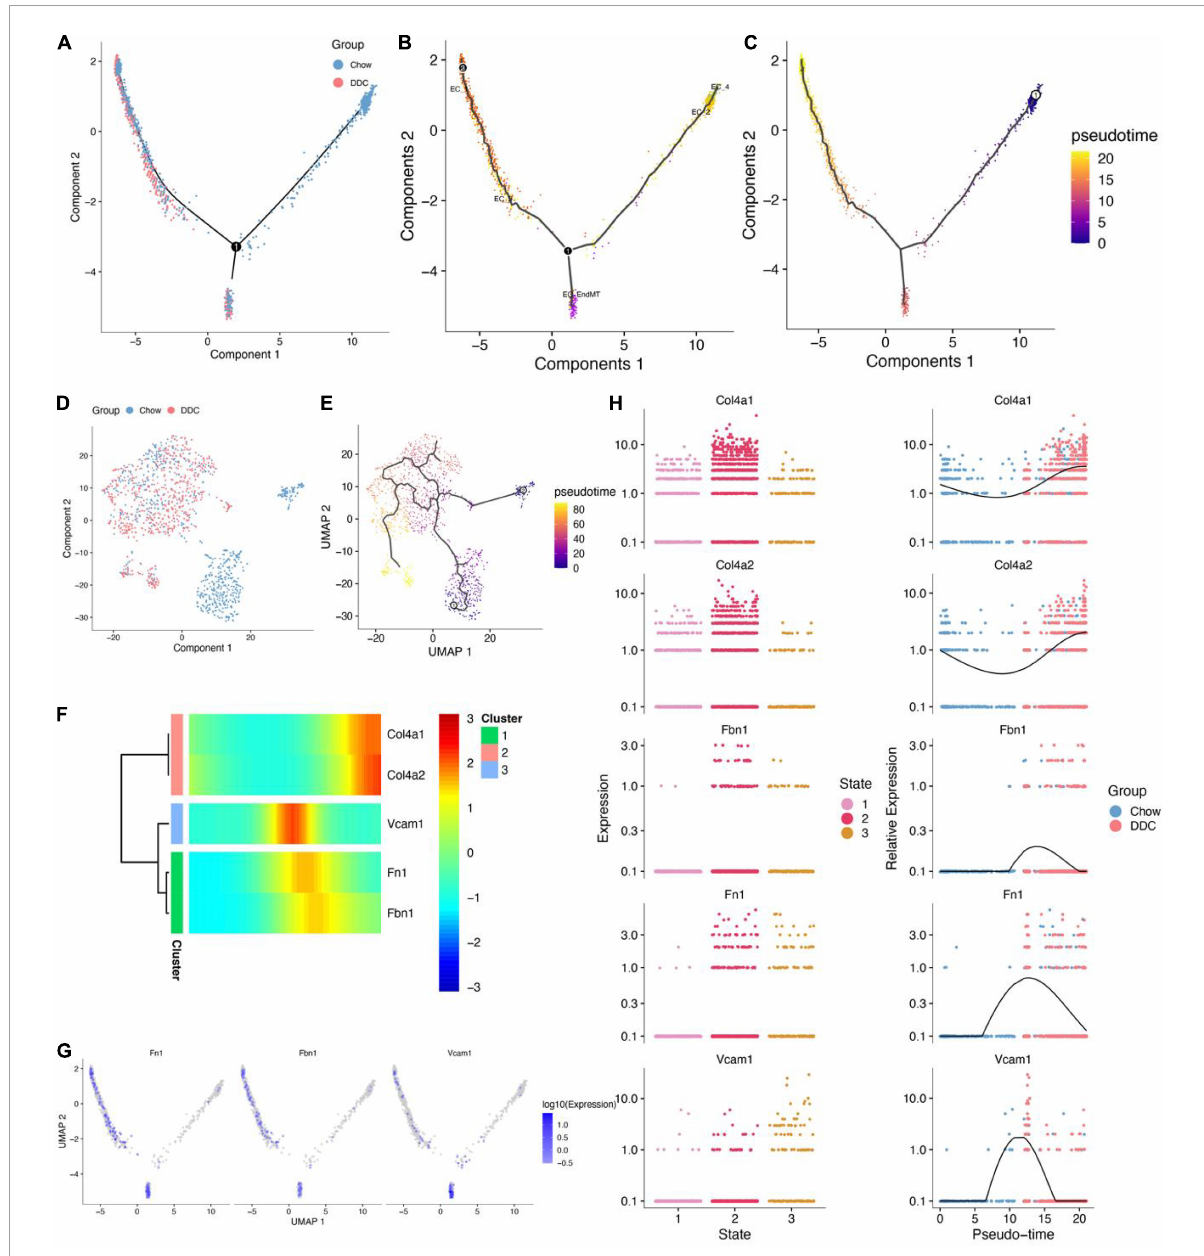
FIGURE3 Cell trajectory analysis of five endothelial cell subtypes. (A) DDRTree plot of endothelial cells between Chow and DDC groups. (B) DDRTree plot showed the various cell subtypes of endothelial cells. (C) DDRTree plot showed the pseudotime of endothelial cells. (D) UMAP plot showed endothelial cells between Chow and DDC groups based on Monocle 2. (E) UMAP plot of pseudotime of endothelial cells. (F) Five important genes (Col4a1, Col4a2, Vcam1, Fn1, and Fbn1) were associated with pseudotime and cell trajectory differentiation of endothelial cells. (G) DDRTree plots of expressions of Fn1, Fbn1, and Vcam1 in endothelial cells. (H) Five important genes were differentially expressed between cell states and their expressions were accompanied by pseudotime. Expressions of Fbn1 and Vcam1 were the highest in the middle segment of the cell trajectory based on